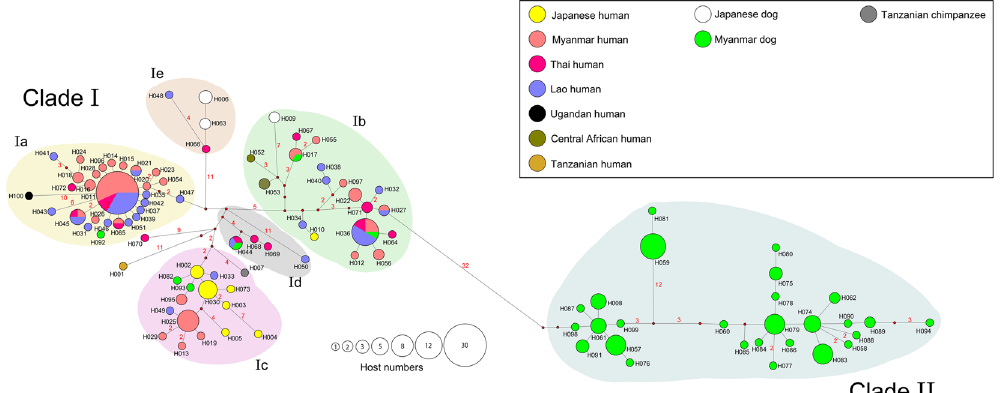
Figure 2. Median-joining haplotype network for the mitochondrial Cox1 gene. Each circle represents one haplotype. The size of the circle represents the number of hosts that harbor the given haplotype. The color inside the circle indicates the host species/geographical origin (country). Numbers beside the branches indicate the number of mutational steps between haplotypes (no number is shown in case of a single-step difference). Branch lengths are roughly proportional to the number of mutational steps.